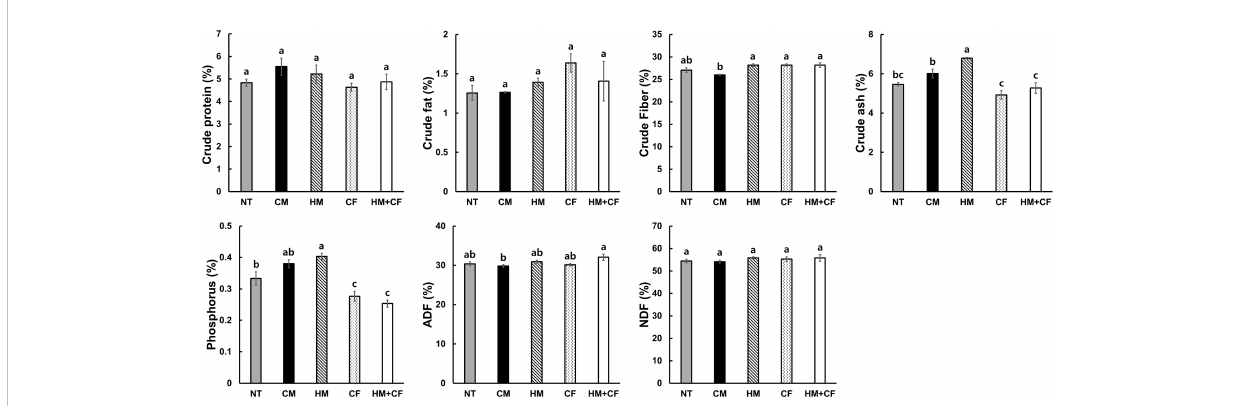
FIGURE 2 Feed values differ after applying different fertilizers (NT, non-treatment; CM, commercial manure; HM, Hanwoo manure; CF, chemical fertilizer; HM+CF, combined use of Hanwoo manure and chemical fertilizer). The values are the mean ± standard deviation (n = 3). The lowercase letters represent the signi fi cant differences (p < 0.05) between groups using the Duncan test.